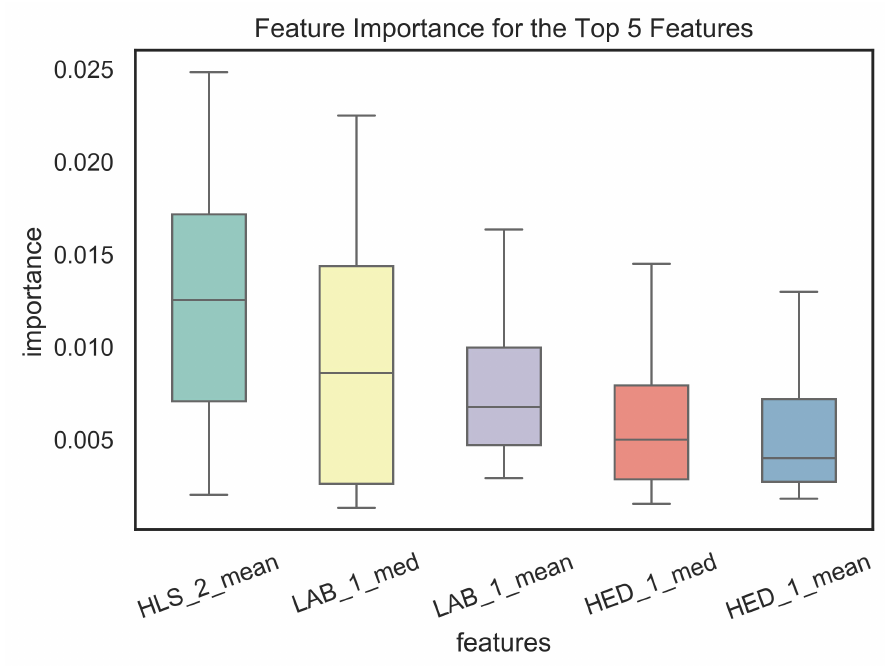
Figure 13. The boxplot for different feature types in different images. The distribution of the color feature in the box plot shows that it is the most effective feature among the three types of features.